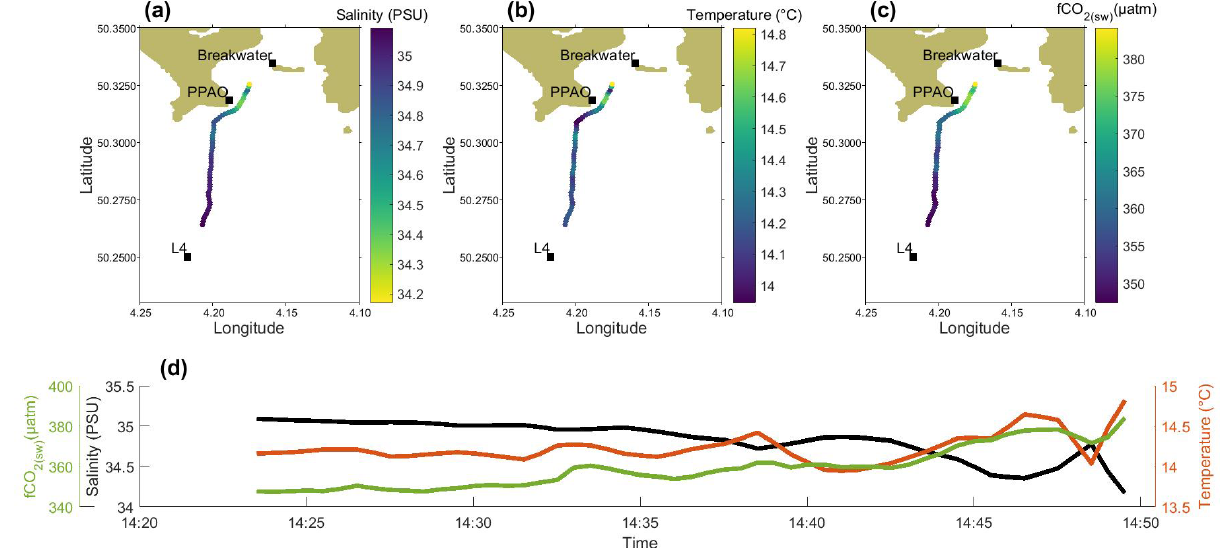
Figure 6. Example of a high water transect (transect midpoint = LW + 6h). Surface measurements of salinity, temperature and f CO 2 repre- sented spatially (a–c) and as a time series (d) from station L4 toward the coast. Data were collected aboard RV Plymouth Quest on 30 June 2016, (filled circles, data every